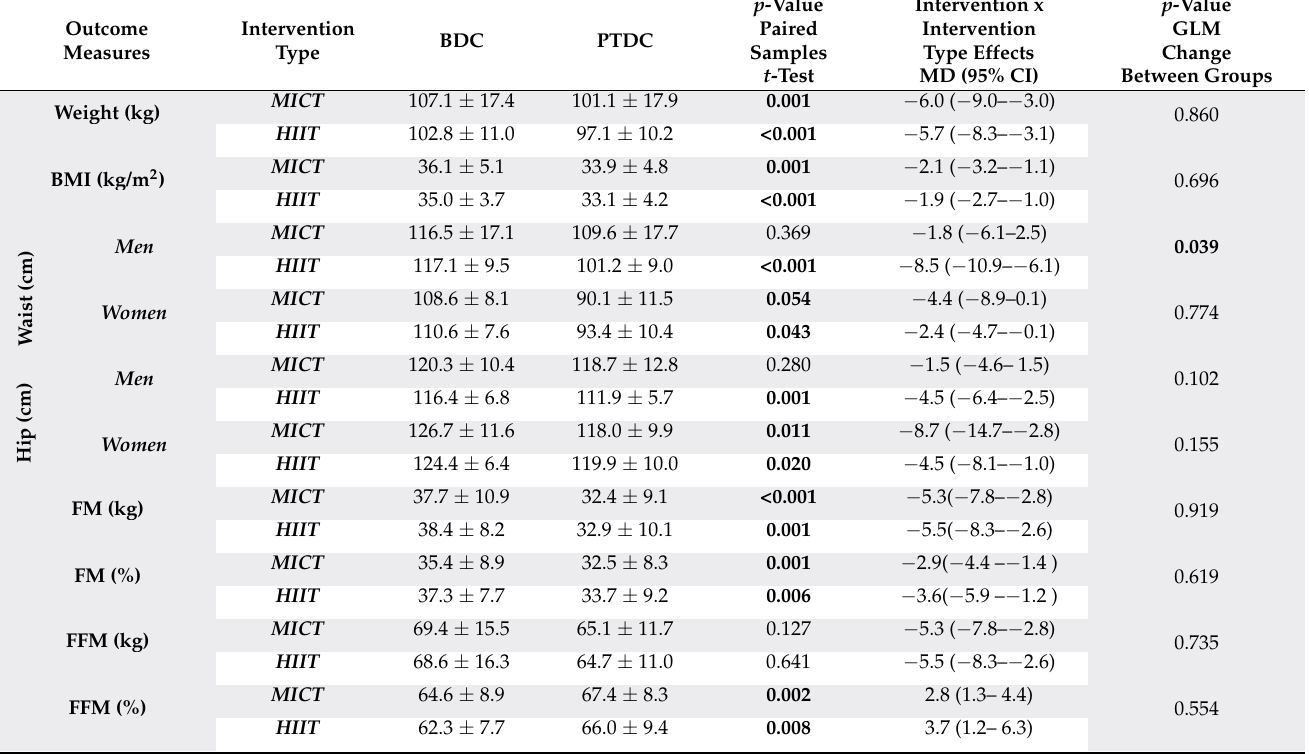
Table 2. Effect of training protocol (MICT vs. HIIT) on body weight, anthropometry, and body